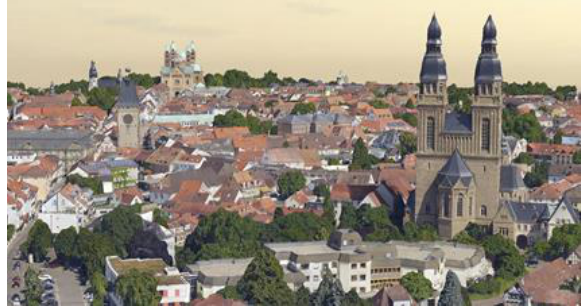
Figure 6. Sreenshot of the resulted texturated 3D city model of the calibration